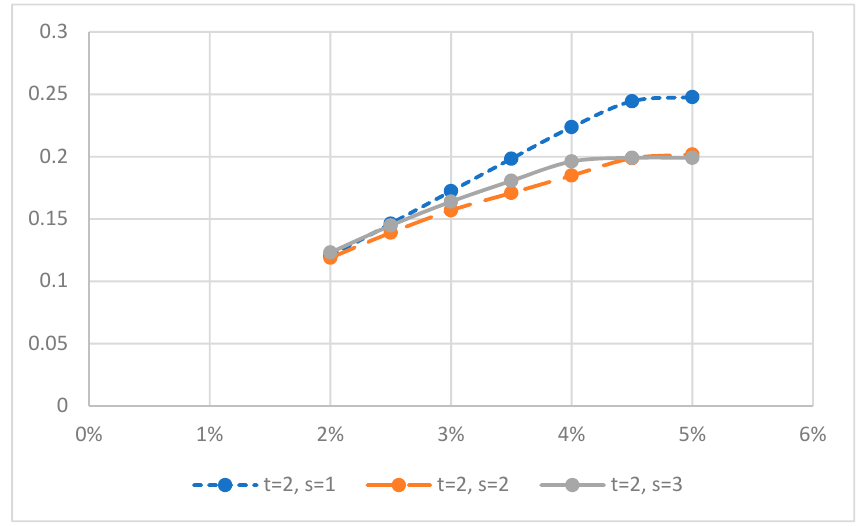
Figure 1. The dimension t = 2 with different s under guaranteed return rate (cid:1868)(cid:3556) (cid:2870) .